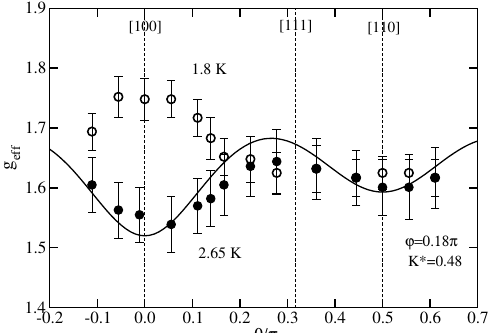
Figure 4. g ef f as a function of θ for the rotation of the magnetic field in the (cid:104) 011 (cid:105) plane for two temperatures ( T = 1.8 K and 2.65 K) from Ref. [44]. The solid curve is the fit to theory [40,43] for T = 2.65 with ϕ = 0.18 π and K ∗ = 0.48. Stronger antiferromagnetic fluctuations are expected at 1.8